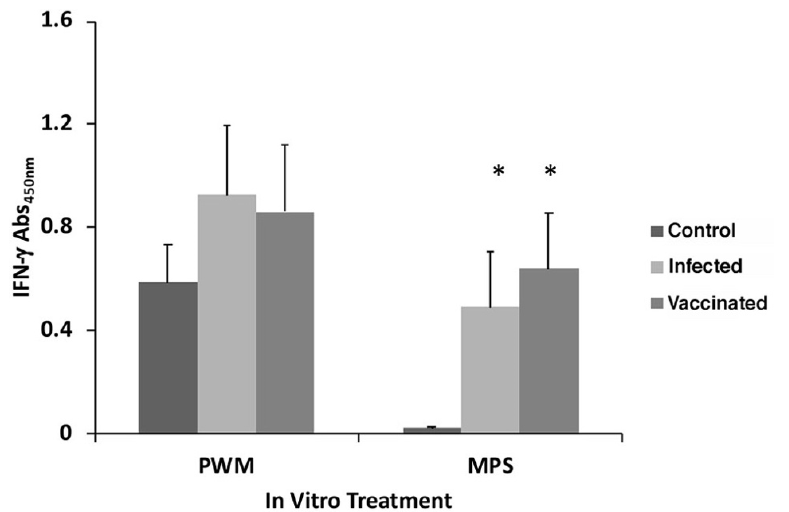
Figure 1. Secretion of IFN- γ from whole blood stimulated for 18-hr in vitro with pokeweed mitogen (PWM) and Map sonicated extract (MPS). Data are the average of duplicate trials ± standard error of the mean. The treatment groups are shown at the right. The asterisk indicates a p value less than 0.05 compared to the control group.